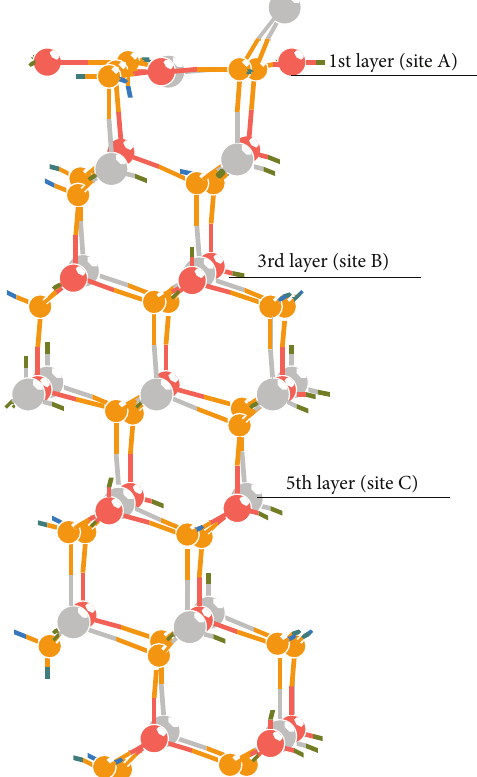
Figure 2: One defect Cd Cu is located at three different sites along the direction [112] , respectively, in the structure including 7 atomic layers and 56 atoms. The red, gray, and yellow balls represent Cu, In, and Se atoms,